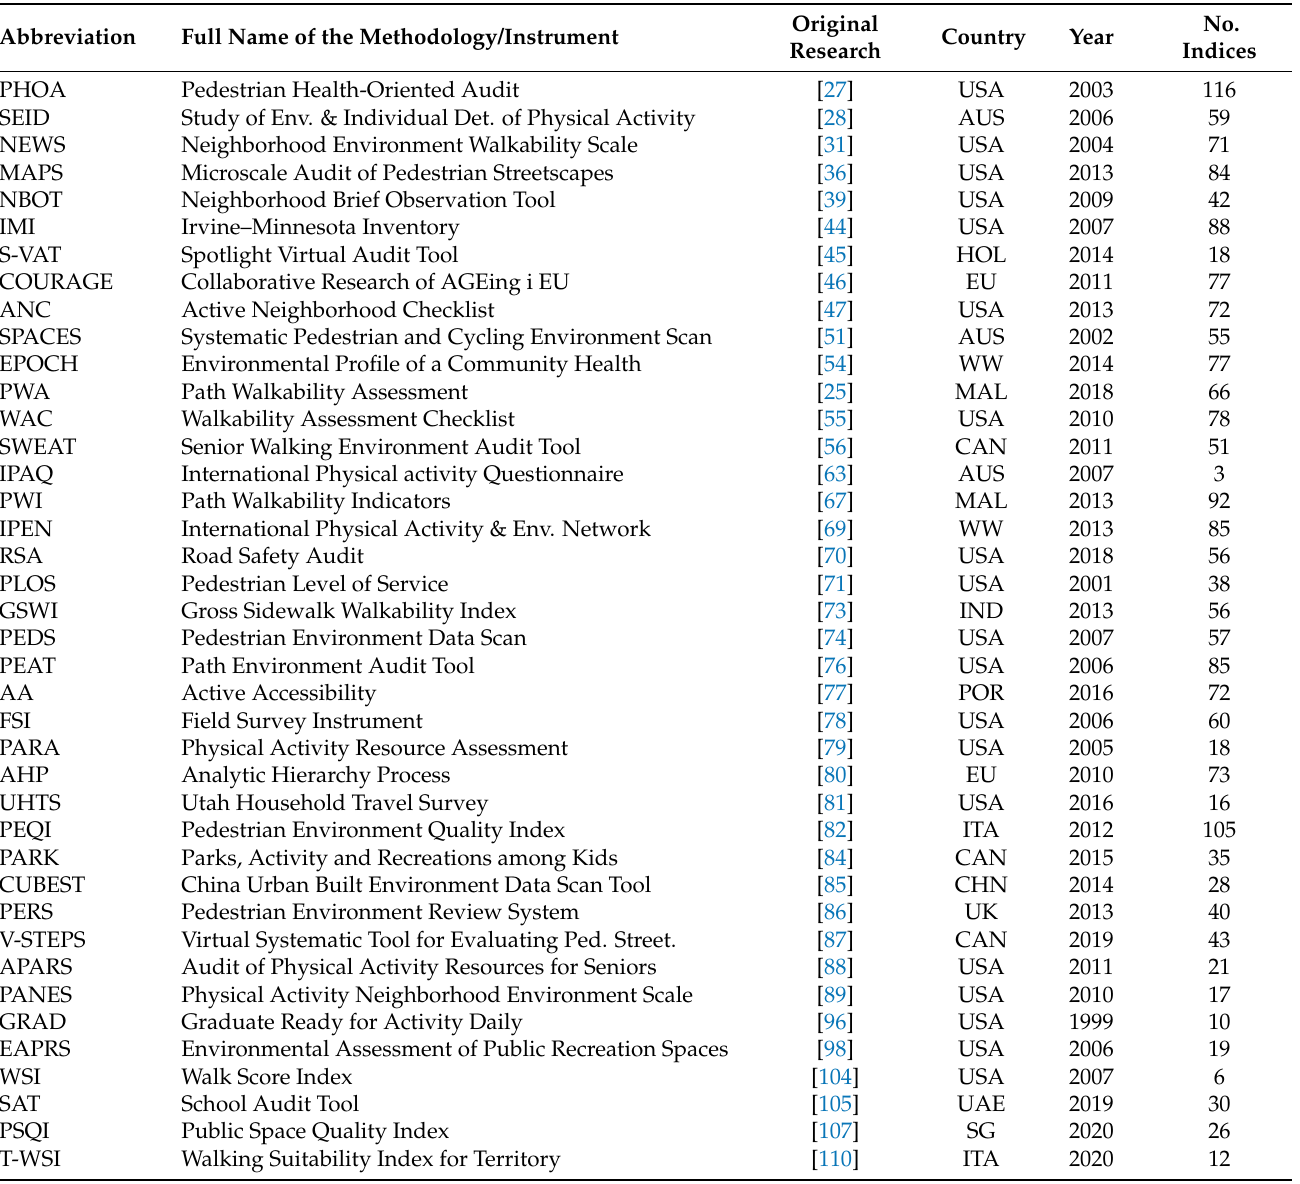
Table 1. List of the relevant methodologies/instruments selected for the analysis—in